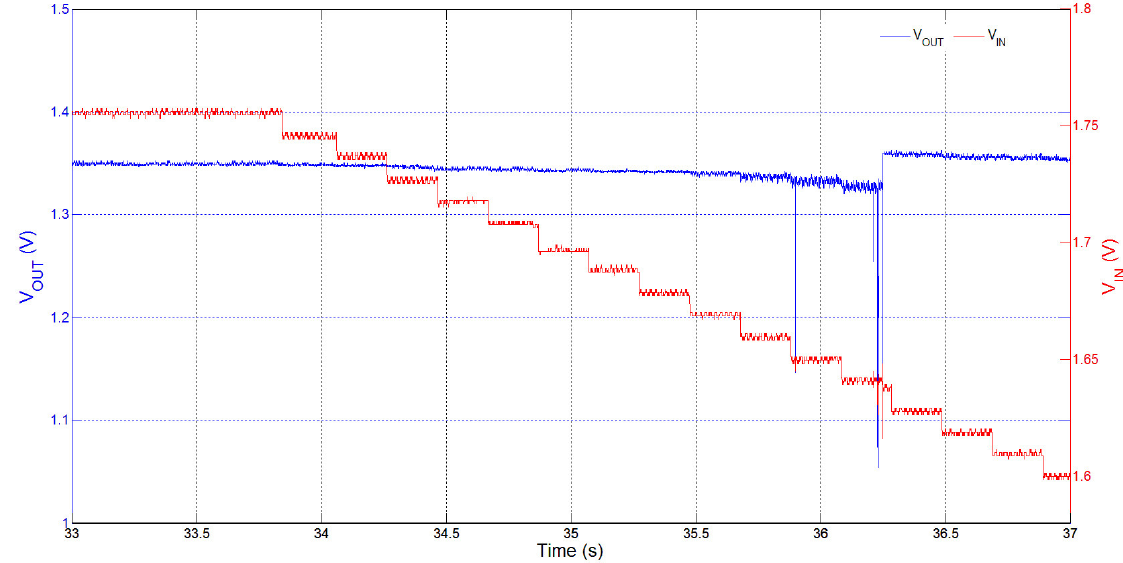
Figure 6. Measured V approximately 1.76 V to 1.60 V in steps of 10